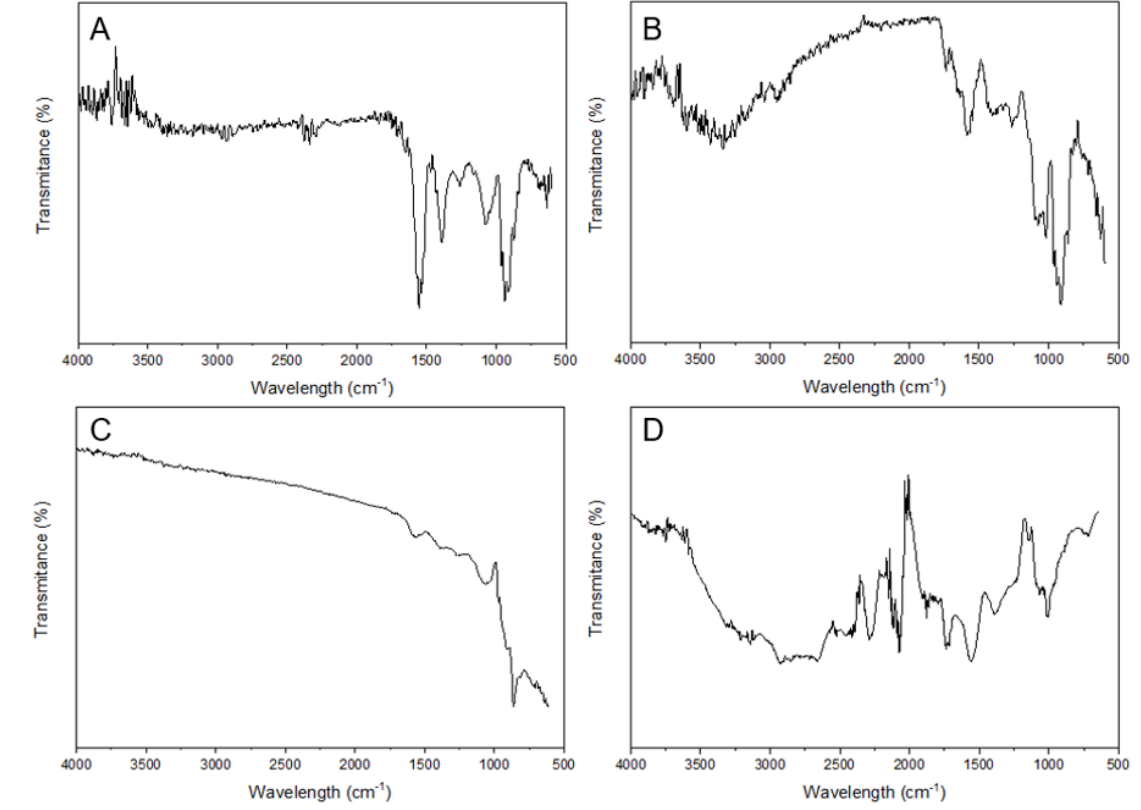
Figure 8. FT-IR spectra of the AgNPs synthesized using citrus peels extracts. ( A ) AgNPs synthesized with lemon extract. ( B ) AgNPs synthesized with orange extract. ( C ) AgNPs synthesized with lemon and grapefruit extract. ( D ) AgNPs synthesized with a mixture of lemon, orange, and grapefruit extracts.